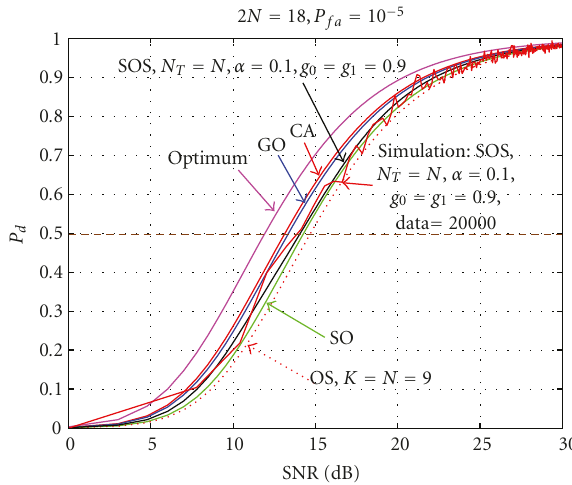
Figure 5: Comparison of P fa in SOS I with di ff erent N T in terms of g 0 = g 1 in homogeneous environment with 2 N = 18.